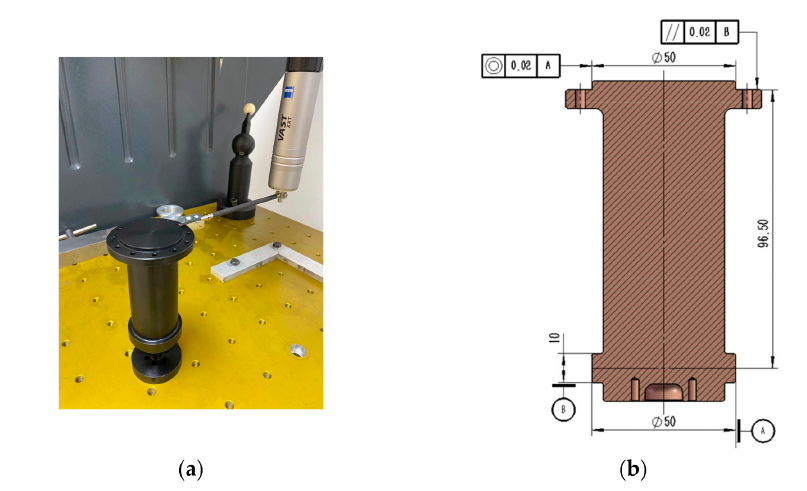
Figure 11. The measurement of the geometric parameters of the front axle. ( a ) measured scene; ( b ) schematic